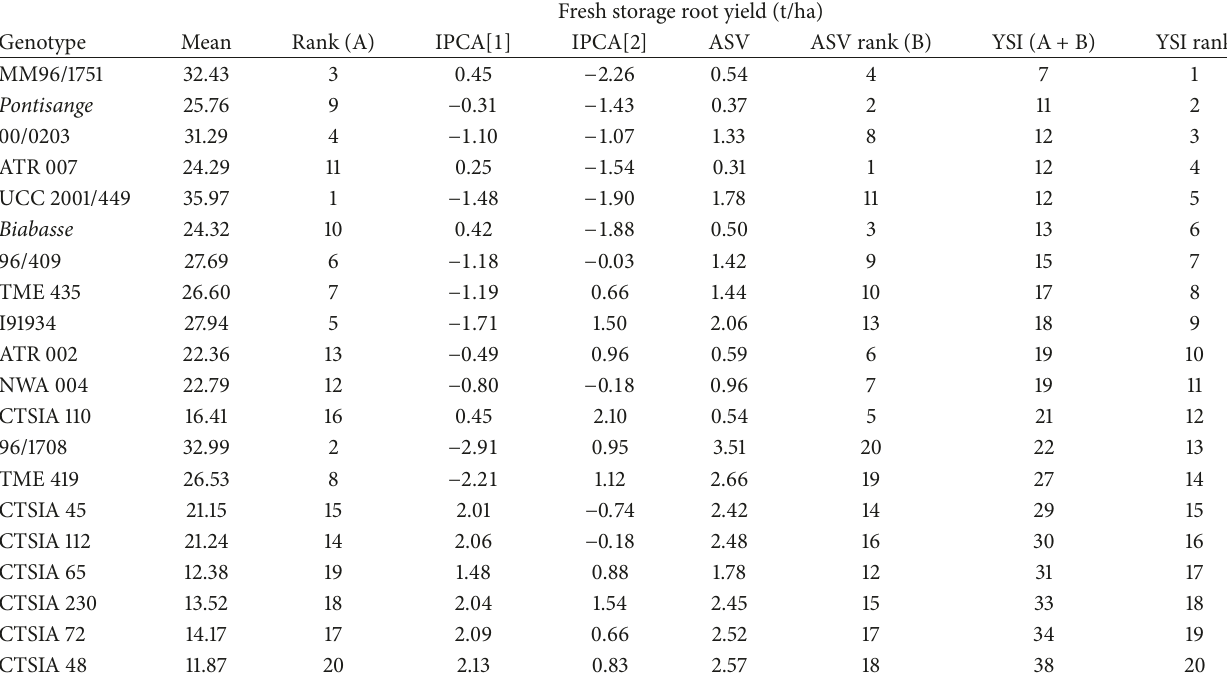
Table 7: Ranking of 20 cassava genotypes based on storage root yield, AMMI stability value (ASV), and yield stability index (YSI) at 12 months after